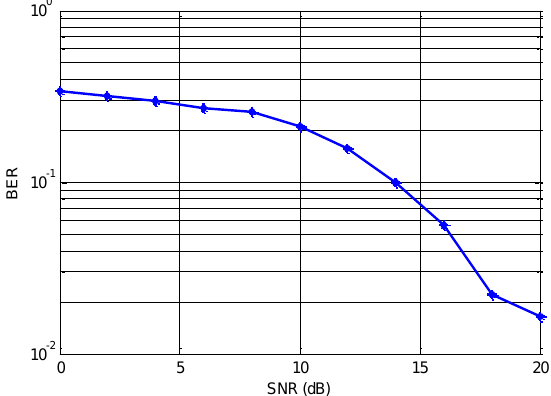
Figure 3: BER Vs SNR for OTFS (number of subcarriers M=8) with